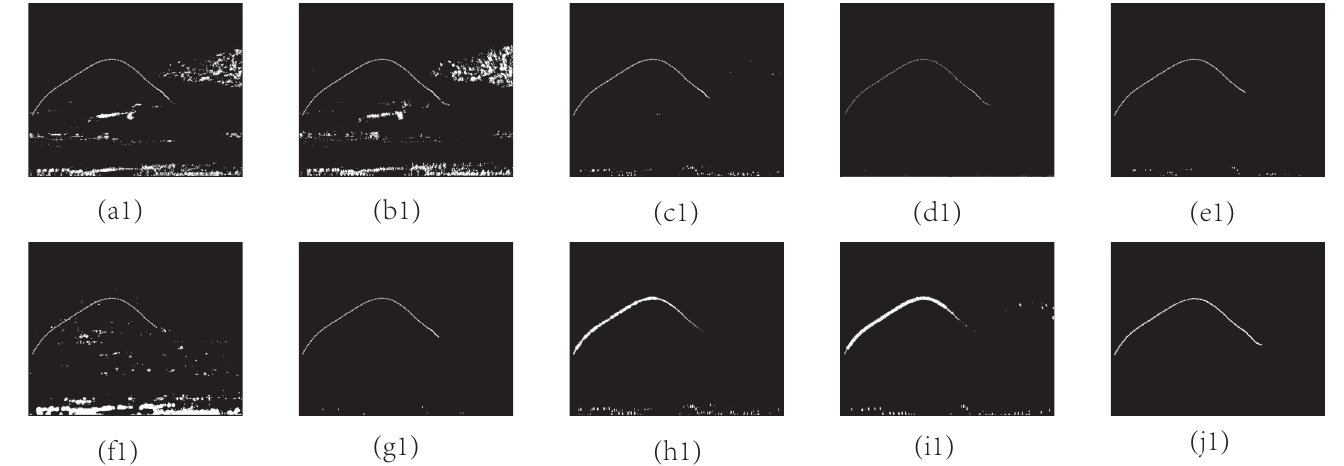
Figure 16. Panels ( a1 – j1 ) shows the detection results of sequence E of top hat, ANI, PSTNN, ASTTV, GST, NTFRA, NRAM, HB-MLCM, ADMD, and the proposed method.